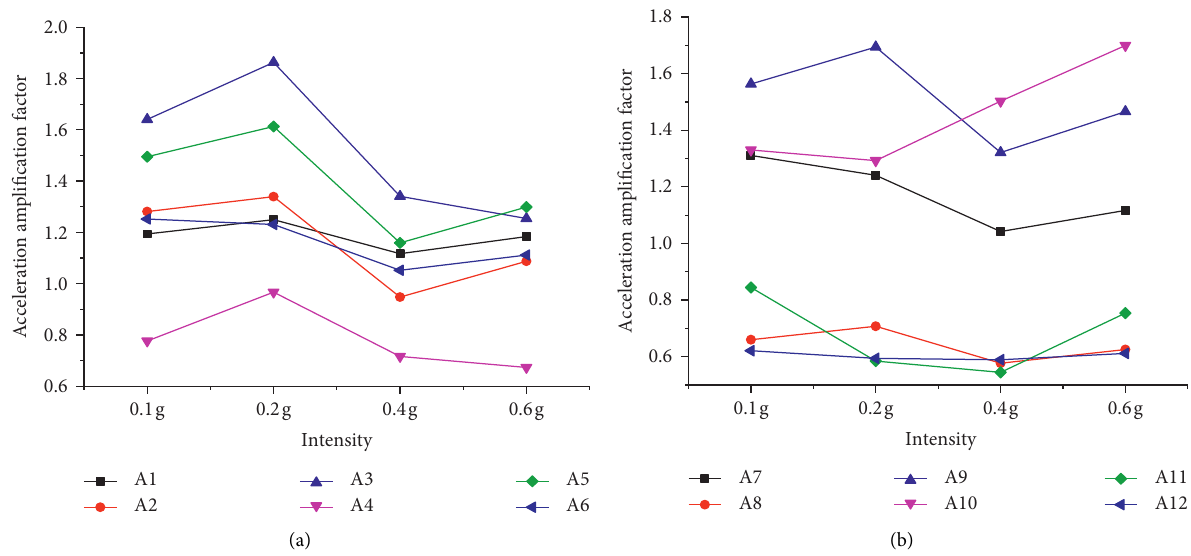
Figure 15: Variation trends of AAF of WC-X in the X -direction at different intensities: (a) left hole and (b) right